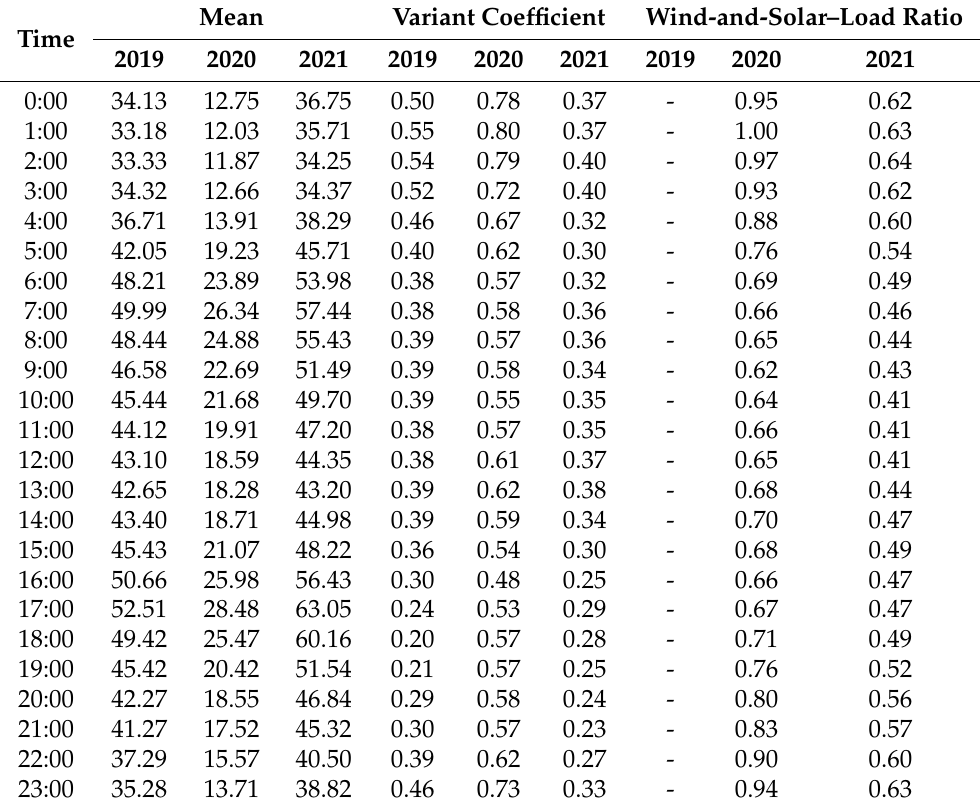
Table 1. Power Data Statistics in Danish DK1